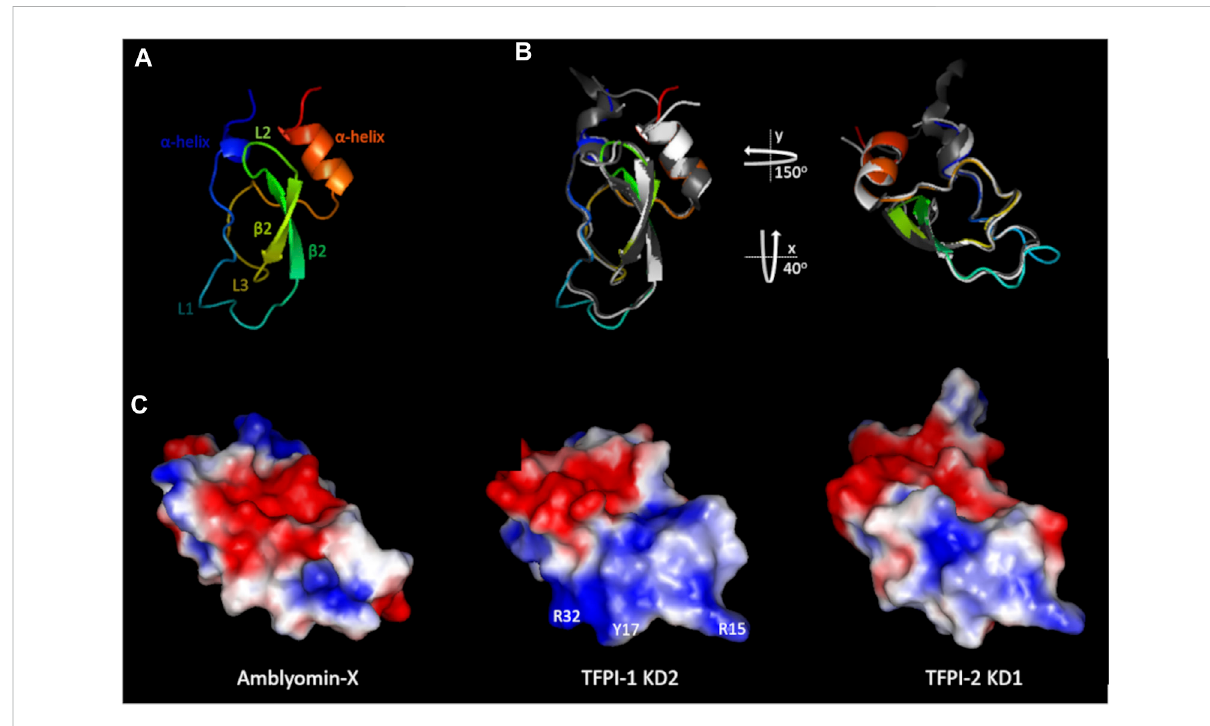
FIGURE 2 Structural features of Amblyomin-X ’ s Kunitz domain. (A) Rainbow colored Amblyomin-X structure model (blue to red). (B) Structure superimposition of the Kunitz domains of Amblyomin-X (rainbow), TFPI-1 KD2 (white), and TFPI-2 KD1 (gray). Structures are shown in two orientations: the same as A (left) and rotated (right) as displayed in (C) (C) Electrostatic potential of the molecular surfaces of the indicated Kunitz domains. Some important residues for TFPI-1 KD2 interaction with FXa (Mesquita Pasqualoto et al., 2014) are indicated. Surfaces negatively charged are shown in red, non-charged in white, and positively charged in blue. For Amblyomin-X homology modeling, boophilin (PDB ID: 2ODY) was used as a template. For TFPI-1 KD2 and TFPI-2 KD1, PDB IDs are 1TFX and 1ZR0,